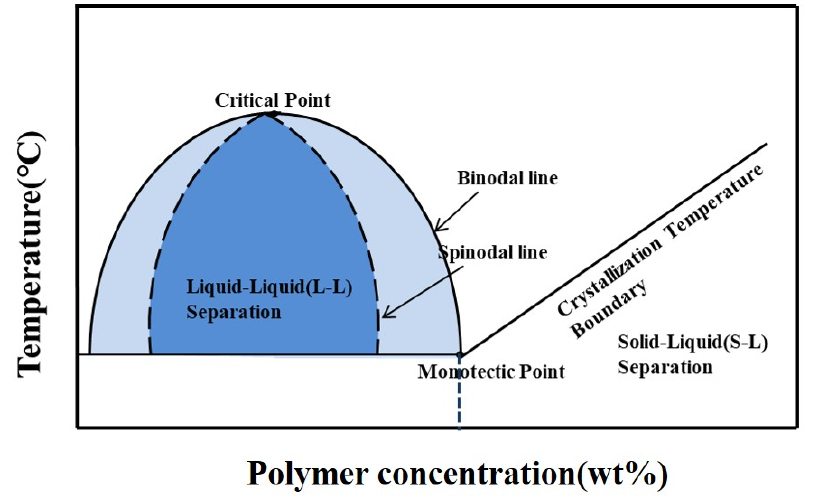
Figure 2. Phase diagram of PVDF/DBM